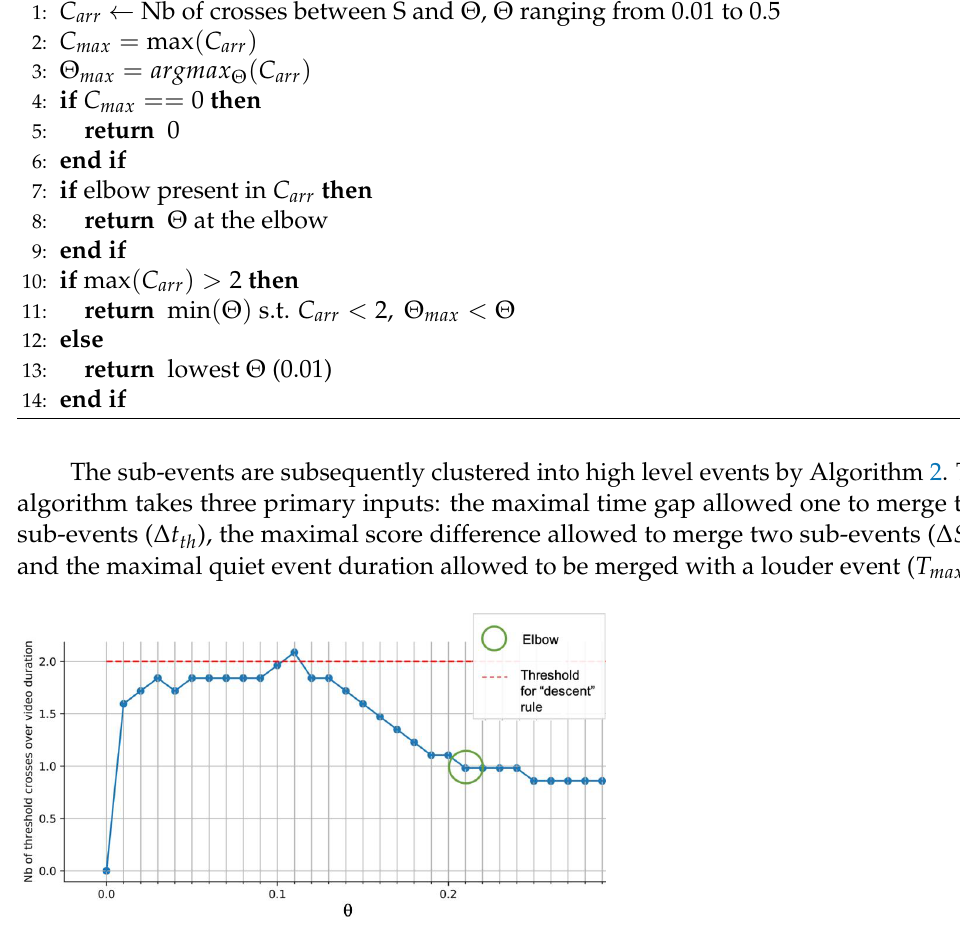
Figure 8. Adaptive threshold search: number of crosses of the threshold Θ by the sound signal. The algorithm is divided into two